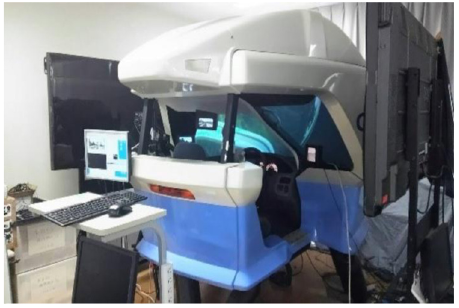
Figure 1 Driving simulator used in the experiment